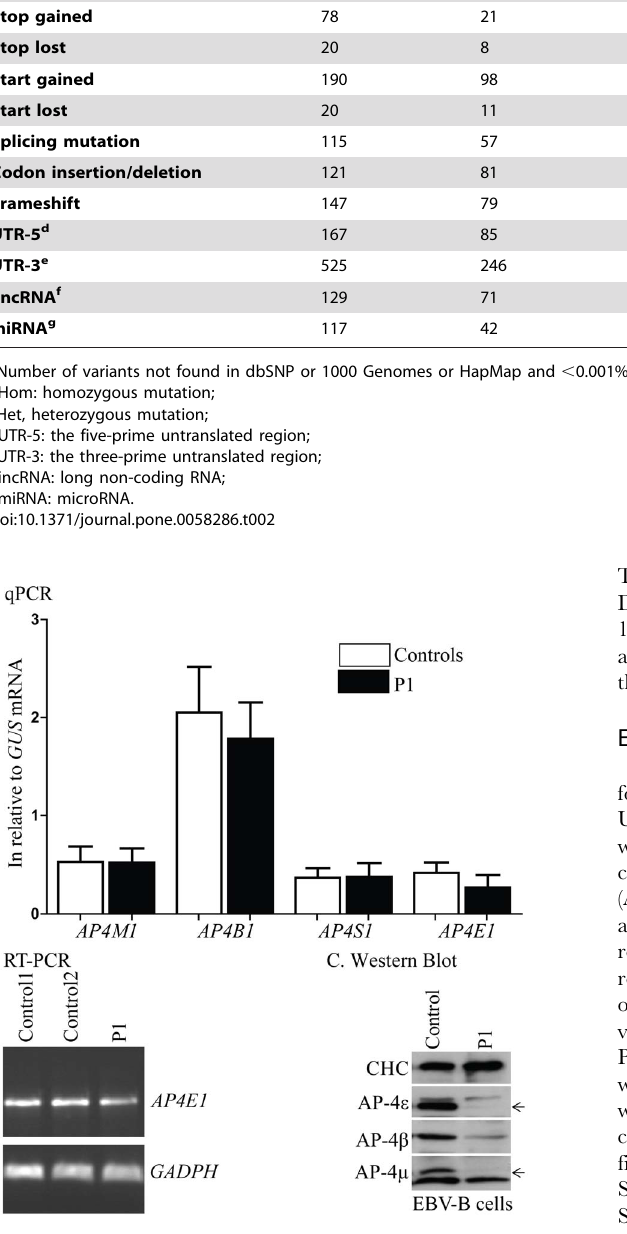
Figure 2. mRNA and protein levels for the subunits of the AP-4 complex. A). RT-qPCR to assess mRNA levels for the components of the AP-4 complex in EBV-B cells from P1. B). RT-PCR to assess the splicing of AP4E1 mRNA. C). Western blot: whole-cell homogenates from EBV-B cells from P1 and a healthy control were subjected to western blotting for clathrin heavy chain (CHC; loading control), AP-4 e , AP-4 b or AP-4 m . The loss of AP-4 e results in a concomitant decrease in the levels of AP-4 b and AP-4 m (specific bands are indicated by an arrow). These experiments were carried out at least twice.